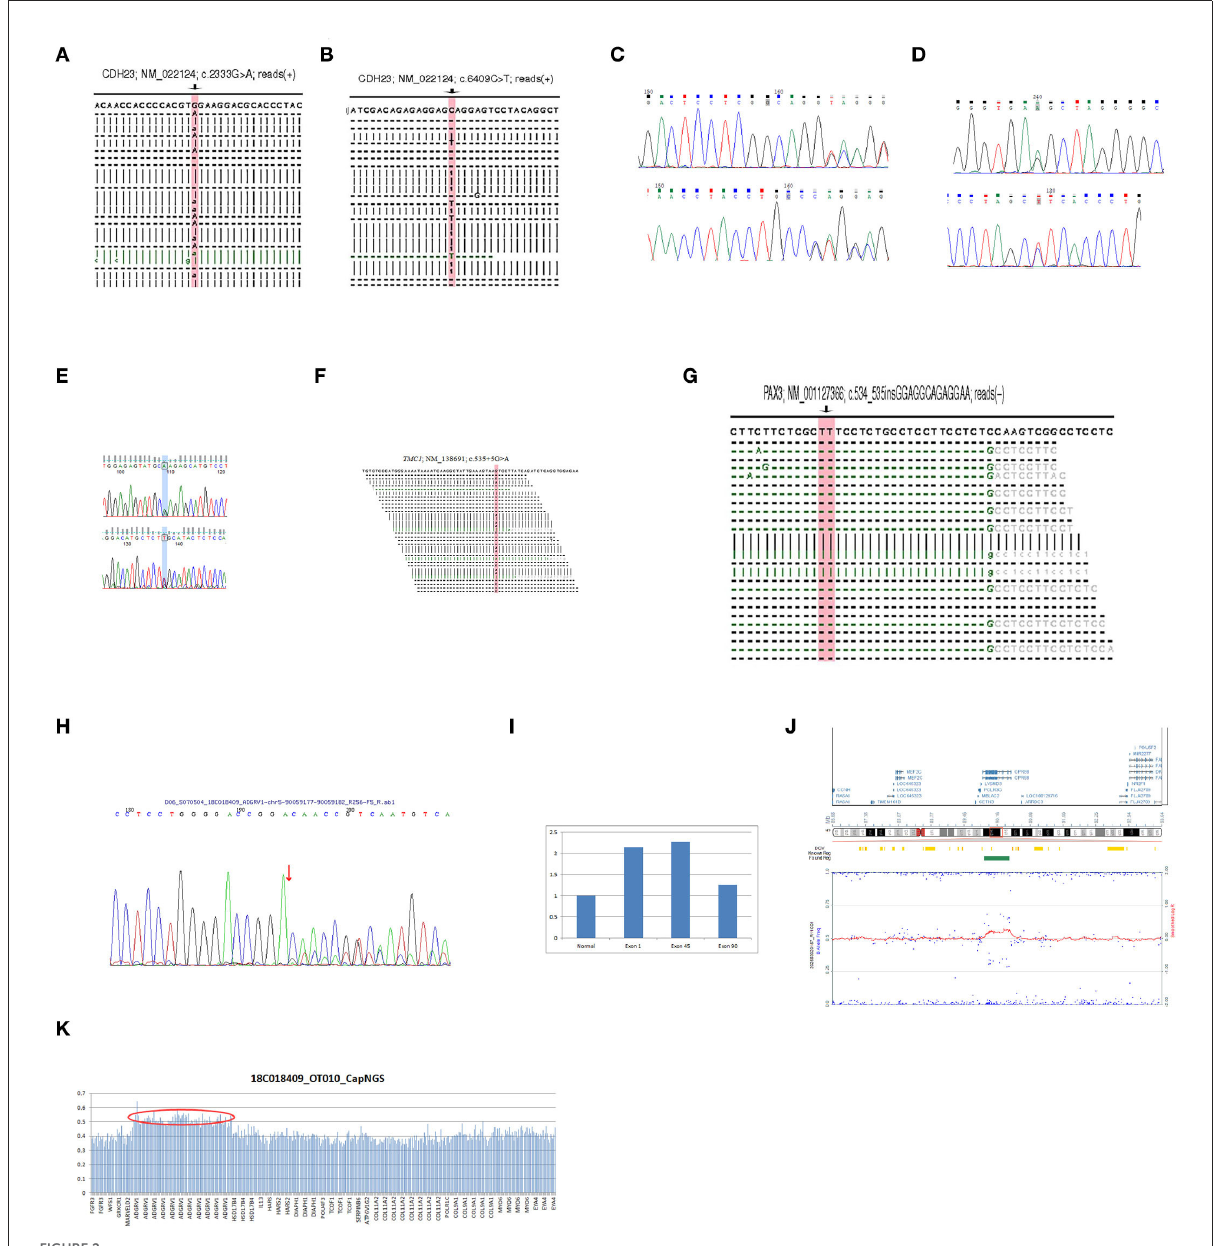
FIGURE2 (A) The NGS result of the mutation c.2333G > A in CDH23 of HL2 proband. (B) The NGS result of the mutation c.6409C > T in CDH23 of HL2 proband. (C) The Sanger sequencing result of the mutation c.3579 + 5G > A in CDH23 of HL3 proband. (D) The Sanger sequencing result of the mutation c.7051_7054 + 1dup in CDH23 of HL3 proband. (E) The Sanger sequencing result of the mutation c.5693G > A in MYO15A of HL4 proband. (F) The NGS result of the mutation c.535 + 5G > A in TMC1 of HL8 proband. (G) The NGS result of the mutation c.534_535insGGAGGCAGAGGAA in PAX3 of HL9 proband. (H) The Sanger sequencing result of the mutation c.12177_12181delGGTTG in ADGRV1 of HL5 proband. (I) The qPCR results of the exon 1, 45, and 90 in ADGRV1 of the HL5 proband contrast to normal. (J) The SNP array result of the proband HL5. (K) The NGS result of the HL5